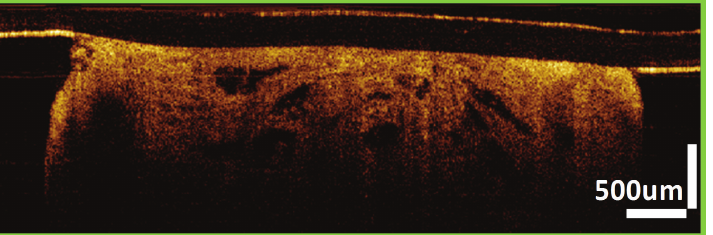
Figure 3: Intramucosal esophageal adenocarcinoma. OCT image showing dense large glands within the specimen. Lamina propria and muscularis mucosae (MM) layers are not clearly visible due to the infiltration of metaplasia into the MM